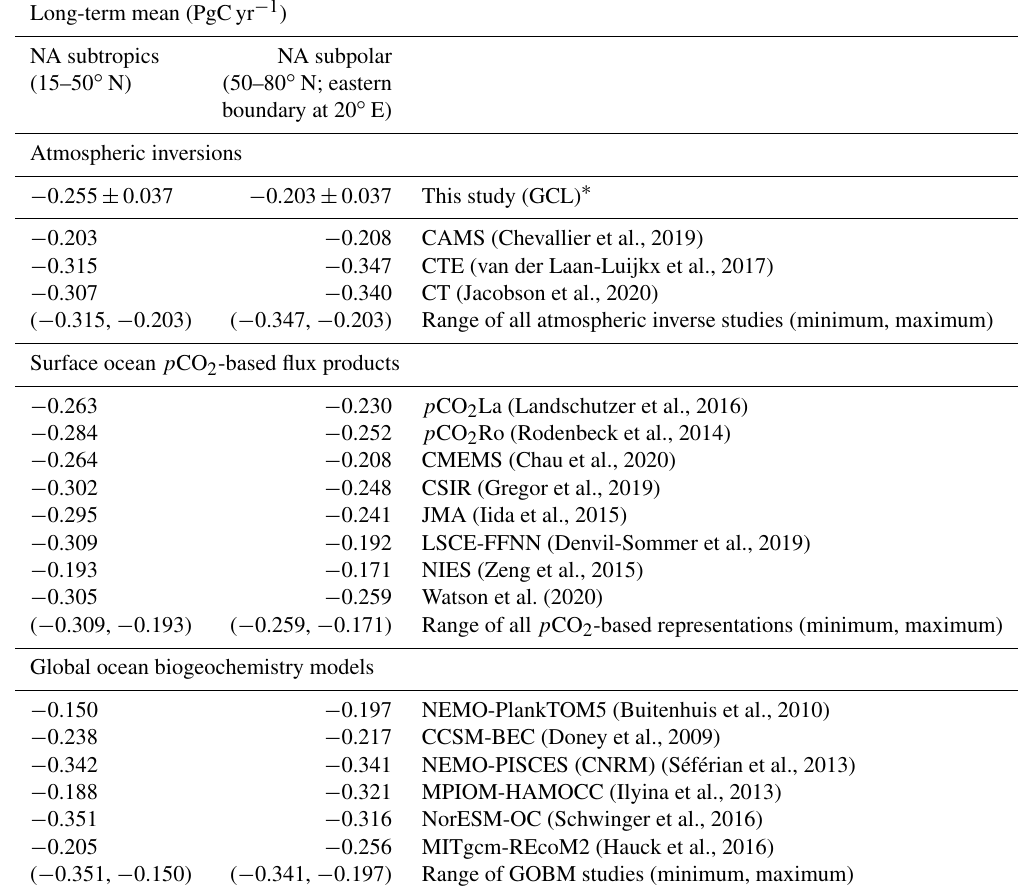
Table 2. Summary metrics of GEOS-Chem–LETKF North Atlantic (NA) CO 2 flux estimates and comparison with independent estimates (from atmospheric inverse analyses, surface p CO 2 mappings, and global ocean biogeochemistry models (GOBMs)) for the period 2000– 2017. Listed are estimates for the long-term mean. The metrics listed in this table are plotted in Fig. 3a and